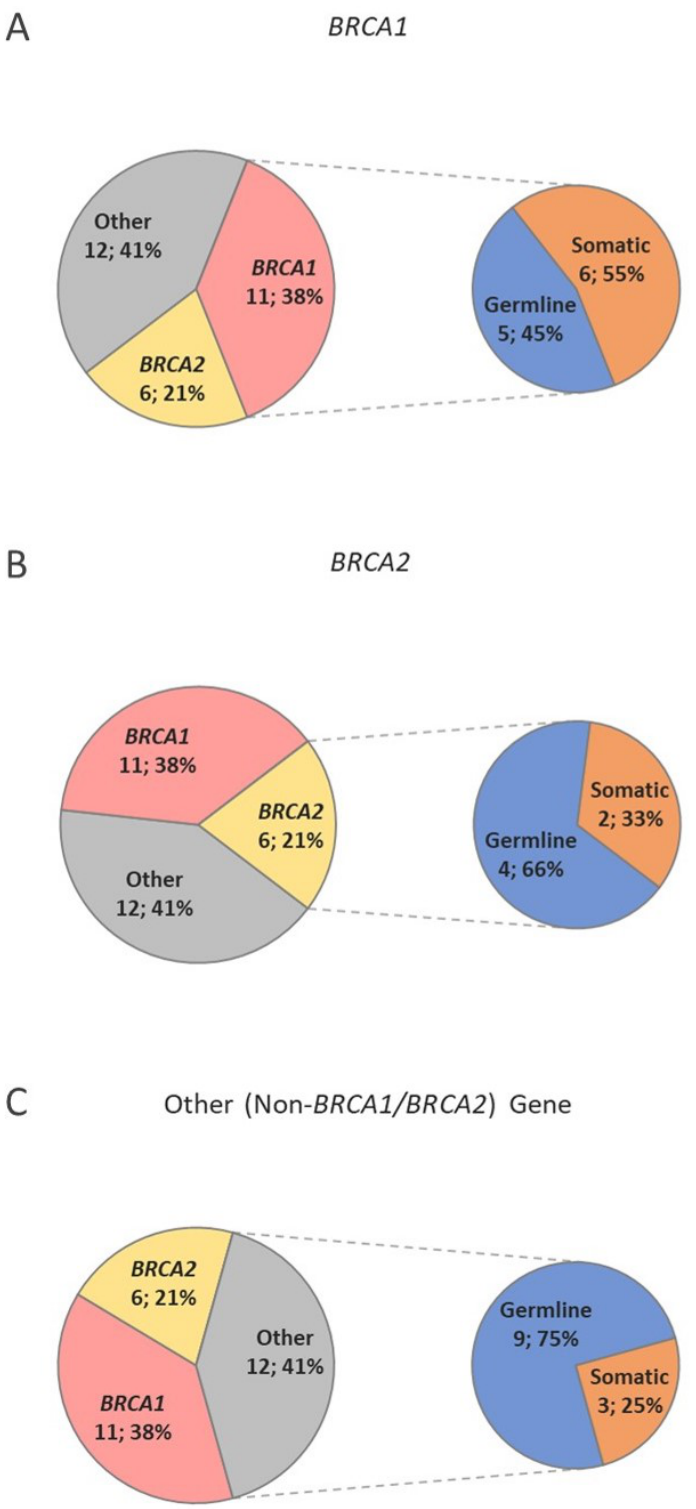
Figure 4. Distribution of all sequence variants between BRCA1 , BRCA2 and another HCP gene ( APC , BRIP1 , CDKN2A , MSH3 , MUTYH , PALB2 , PTEN , RAD51C, and RAD51D). Distribution of variant origins are demonstrated for BRCA1 ( A ), BRCA2 ( B ), and other HCP genes ( C ). The other category demonstrates a high proportion of germline variants that would not be detected with isolated BRCA1 and BRCA2 tumour